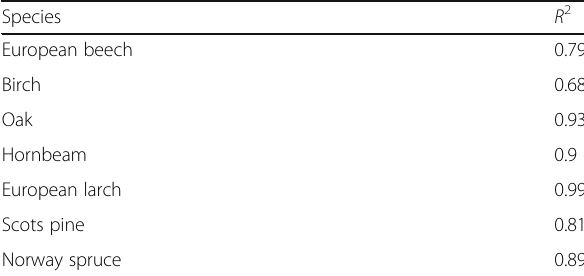
Table 4 Coefficient of determination between the number of trees (%) and the classification results (%) of individual species on individual test plots